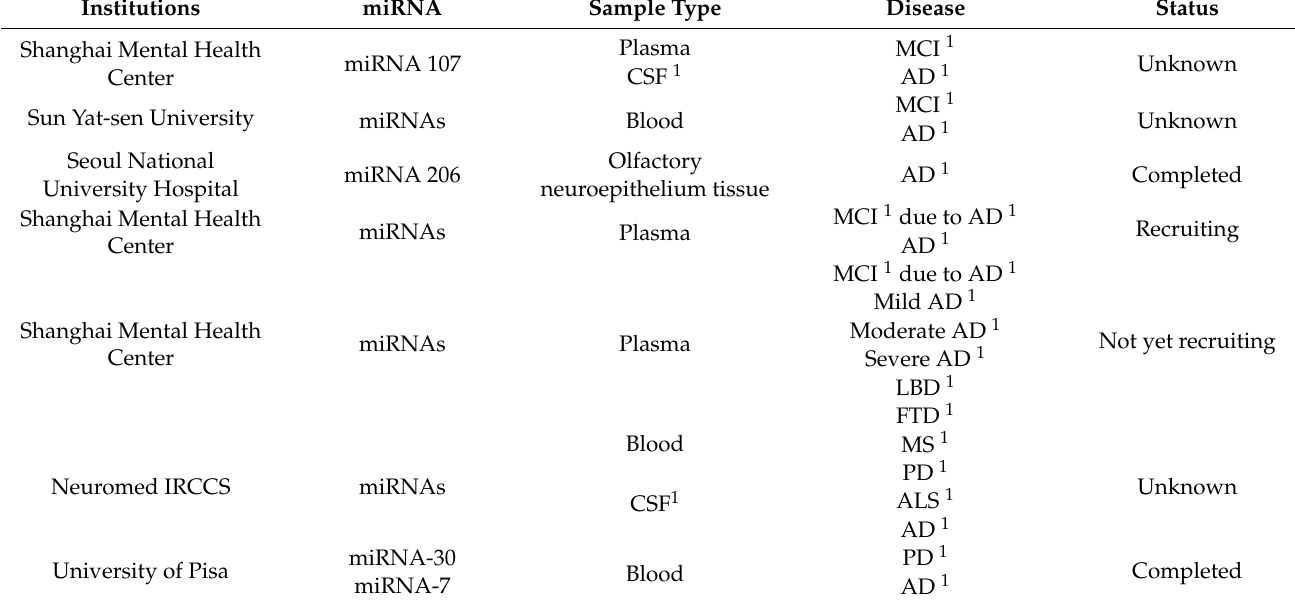
Table 2. Clinical trials showing the potential diagnostic of AD using miRNAs as